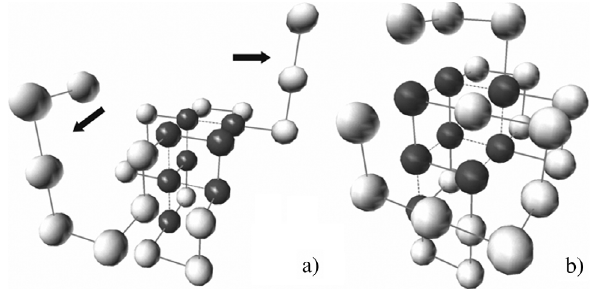
Figure 1 - Structures from case 27.9 under the different models. A: origi- nal model, the arrows point to unnaturally extending ends. B: modified model, the ends are now folded around the hydrophobic core. Dark spheres are hydrophobic monomers and white spheres polar ones. The dotted line indicates a hydrophobic contact and the continuous line is the backbone. The number of hydrophobic contacts, compactness and segre- gation values are given on Table